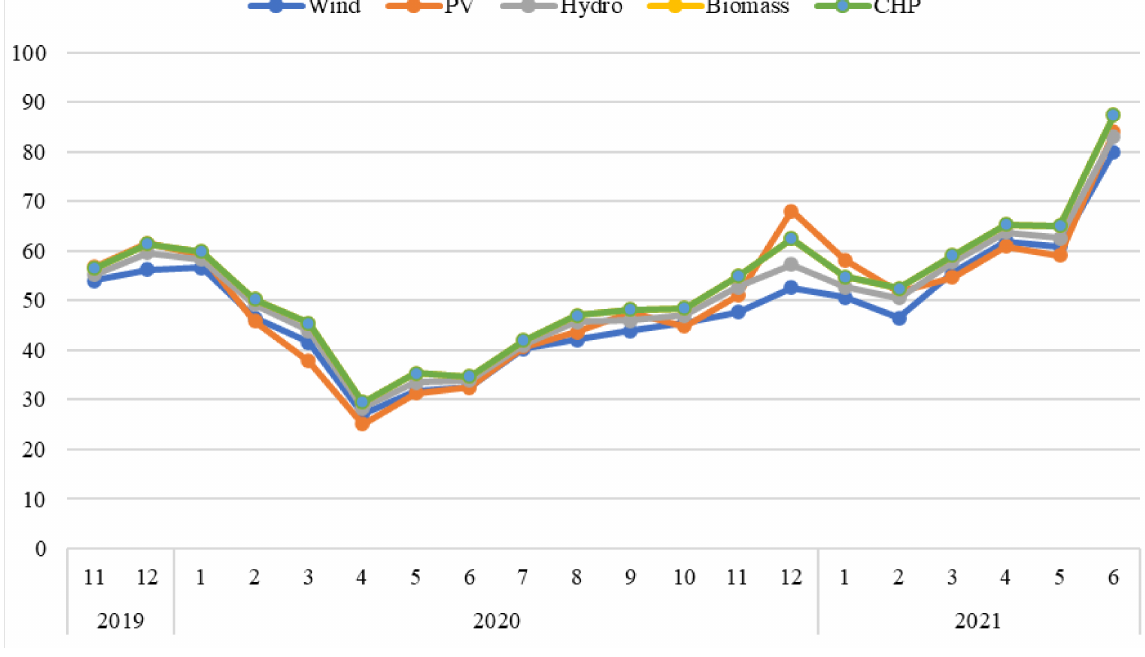
Figure 19. Reference Market Price in Greece ( € /MWh), (November 2019–June 2021), Source: Hellenic Energy Exchange and Authors’